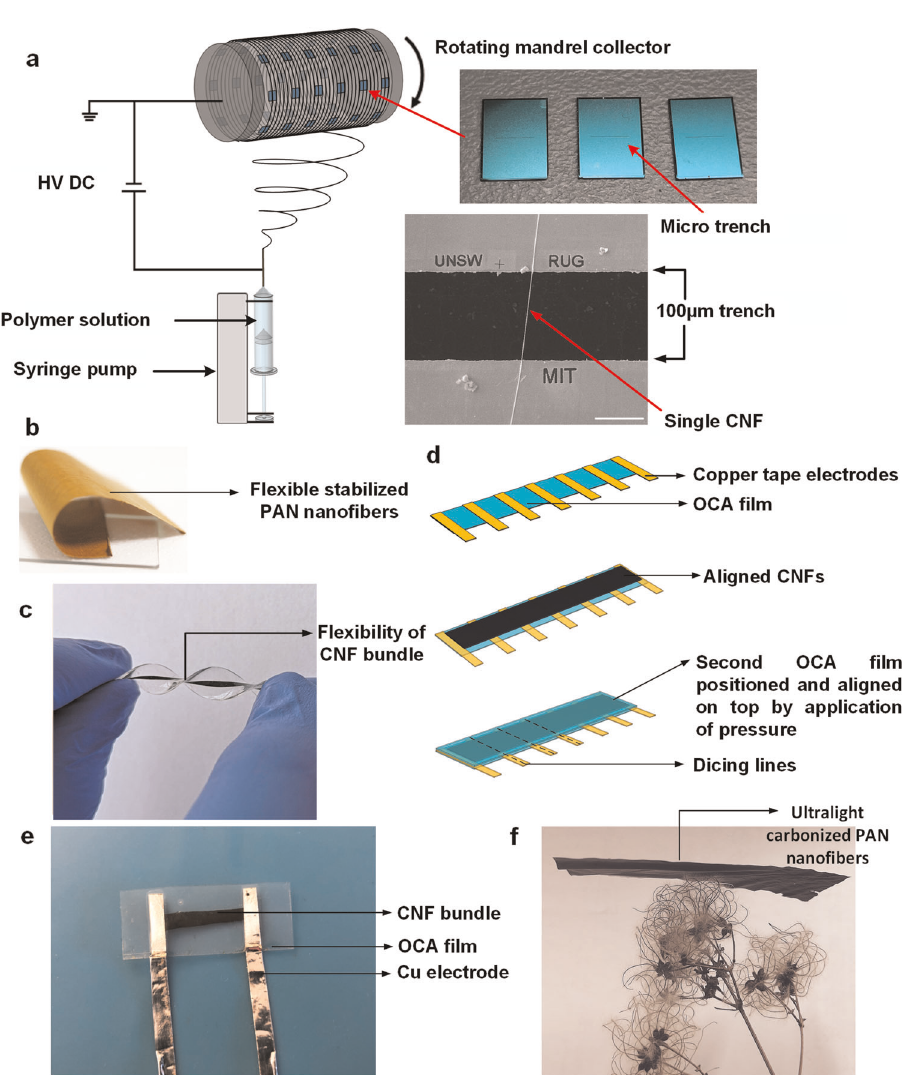
Fig. 6 CNF bundle strain sensor. a Schematic of the electrospinning setup for single PAN nano fi bers across micro-trench and nano fi ber bundles on an aluminum foil substrate; photograph of the fabricated micro-trench sample; SEM image of electrospun single PAN nano fi bers across the micro-trench. b Flexible stabilized electrospun PAN nano fi bers. c CNF bundle embedded in PDMS substrate in fl exed position demonstrating excellent fl exibility. d Schematic diagram of elements of the strain sensor. e CNF strain sensor in straightened position. f Flexible ultralightweight carbonized electrospun PAN nano fi bers on a leaf. Scale bar ( a ) = 50 µm.